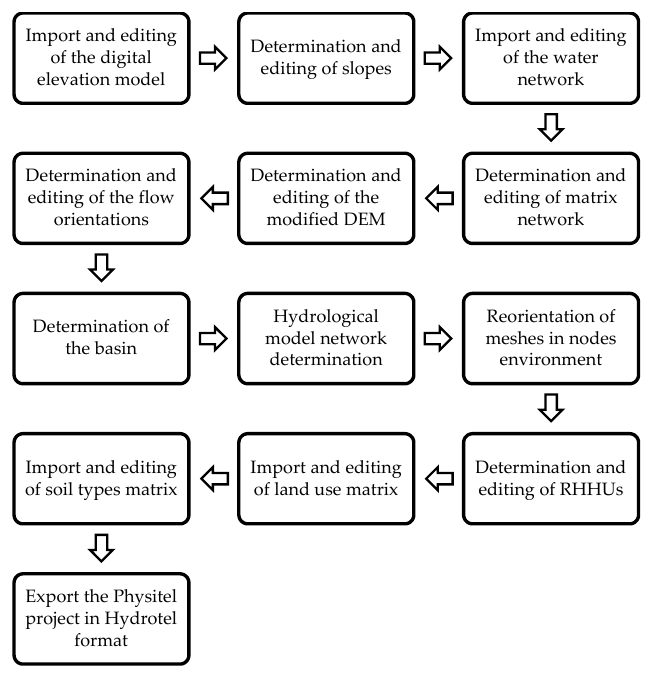
Figure 2. Stages of the physiographic characteristics processing by means of PHYSITEL.